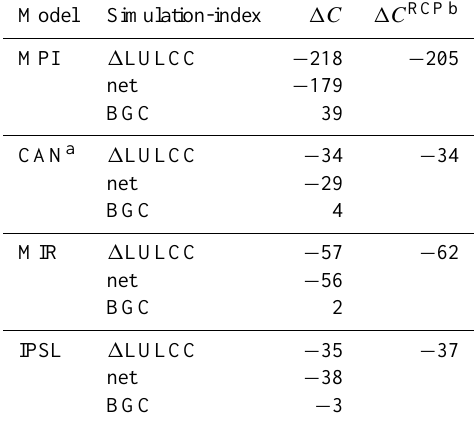
Table 6. Global changes in cumulative land carbon fluxes 1C (cu- mulative from 2006 until 2100 in GtC) in 2100 due to the various effects of LULCC: changes in vegetation distribution and